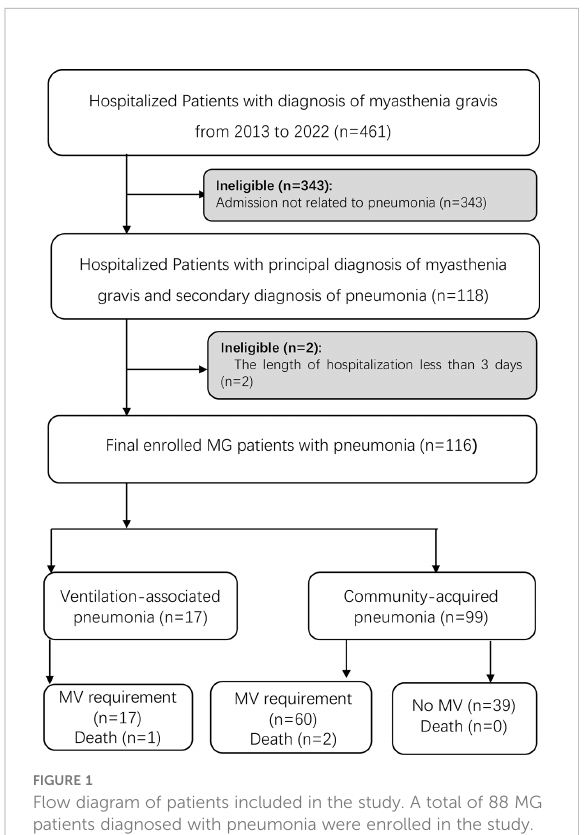
FIGURE 1 Flow diagram of patients included in the study. A total of 88 MG patients diagnosed with pneumonia were enrolled in the study. MG, myasthenia gravis; MV, mechanical